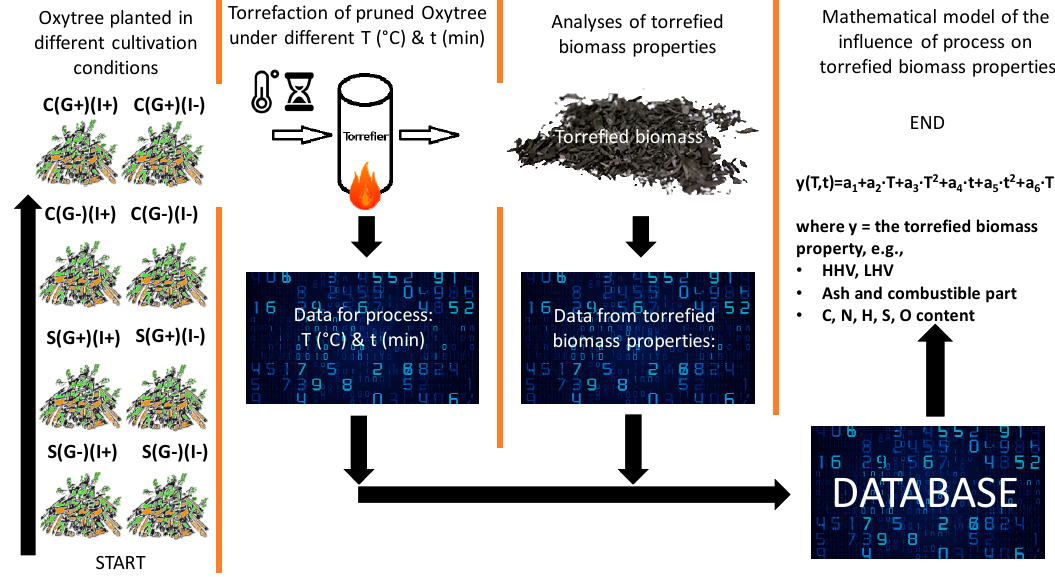
Figure 2. Diagram of experimental design and data evaluation.